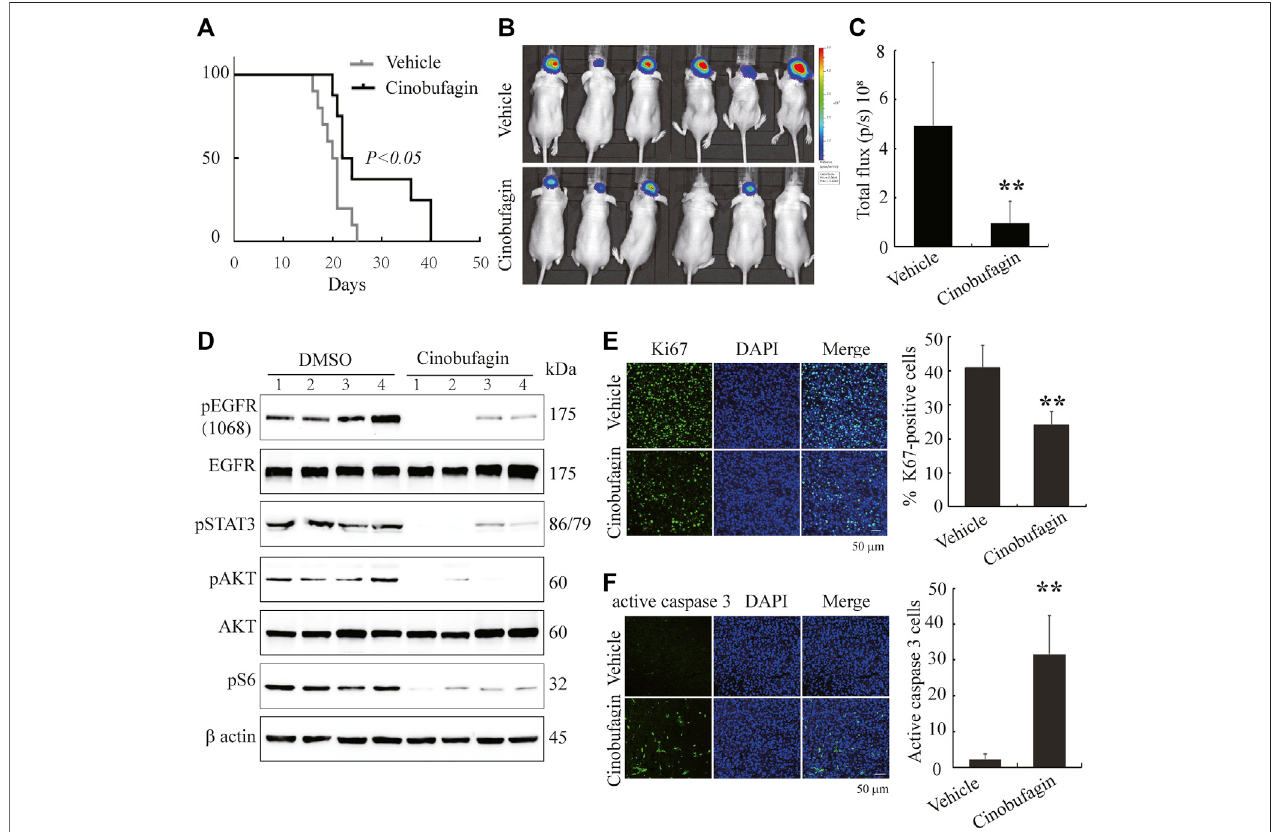
FIGURE6| CinobufaginsuppressestumorgrowthofU87MG-EGFRcellsandelongatesnudemicelifespan. (A) Survivalcurvesofbraintumor – bearingmice.After con fi rmation of brain tumor formation by luminance imaging, mice were intraperitoneally injected with vehicle or cinobufagin once a day until the termination of the experiment( n (cid:2) 8forvehiclegroupor10forcinobufagingroup). Thecinobufagintreatment group(23 days)showedasigni fi cantimprovementintheirsurvivalcompared with the vehicle treatment group (20.5 days, p < 0.05). (B) Luminance imaging of individual mice 10 days after cinobufagin treatment. The presence of a glioma is detected through the colorful luminance intensity. (C) Quantitative analysis of intracranial tumor luminance intensity in mice treated with vehicle or cinobufagin. Cinobufagin signi fi cantlysuppressed tumor growth compared withthe vehicle. Datarepresent means ± SD (* p < 0.05, n (cid:2) 6). (D) Cinobufagin inhibits EGFR and STAT3 signaling in intracranial tumor. The tumor tissue lysates from vehicle or drug-treated mice were analyzed by immunoblotting with the indicated antibodies. (E,F) Cinobufagin inhibits cell proliferation and induces apoptosis in intracranial tumor. The immuno fl uorescence staining of Ki67 (E) and active caspase 3 (F) on tumor sections derived from animals treated with or without cinobufagin. Quanti fi cation of Ki67 and active caspase 3 – positive cells in intracranial tumor. Data represent means ± SD. * p < 0.05; ** p < 0.01 compared with the vehicle group.